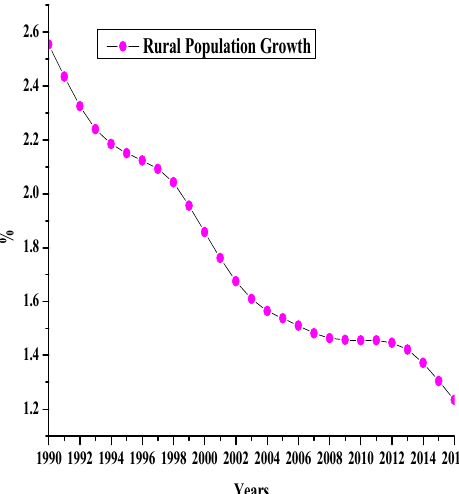
Figure 5. Rural Population Growth in Pakistan.